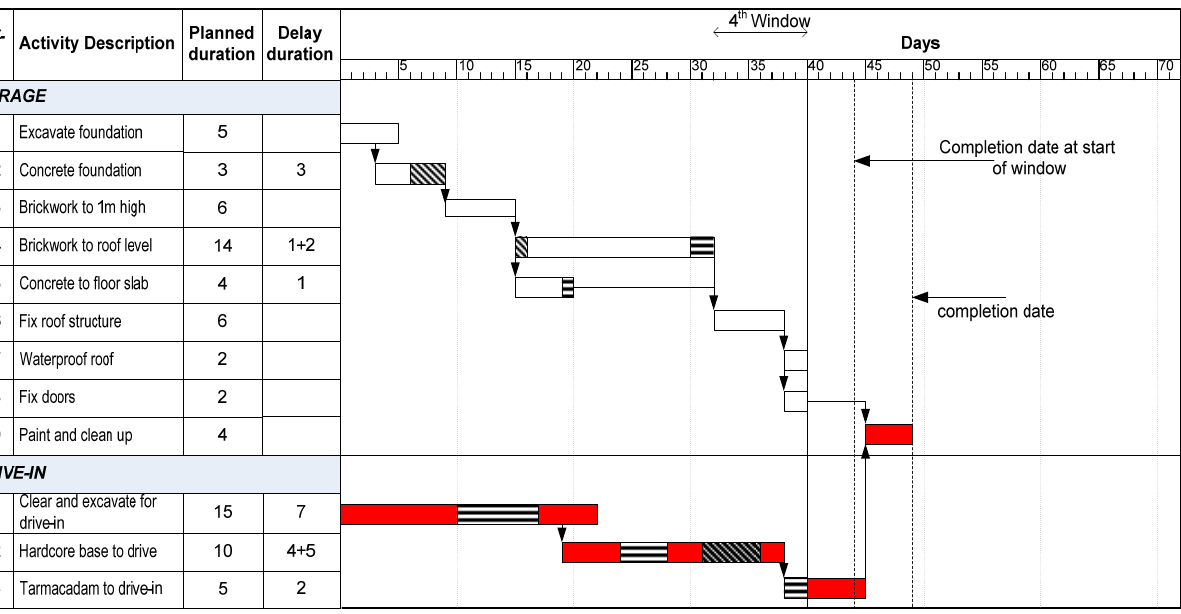
Figure 21. Updated schedule on day 40.